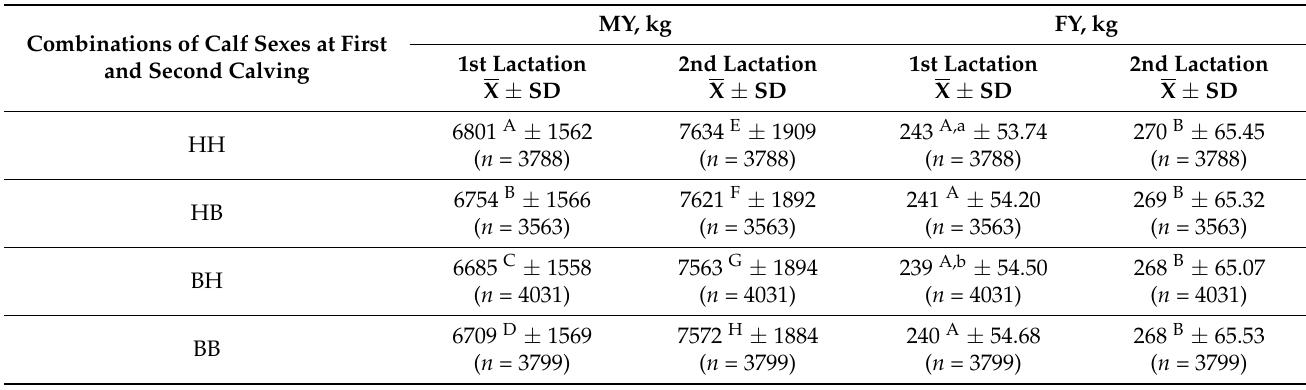
Table 5. Effect of the combination of sex of calves at the first and second calving on milk yield (X ± SD) and fat yield (X ± SD) in the first and second standard lactation. Combinations of Calf Sexes at